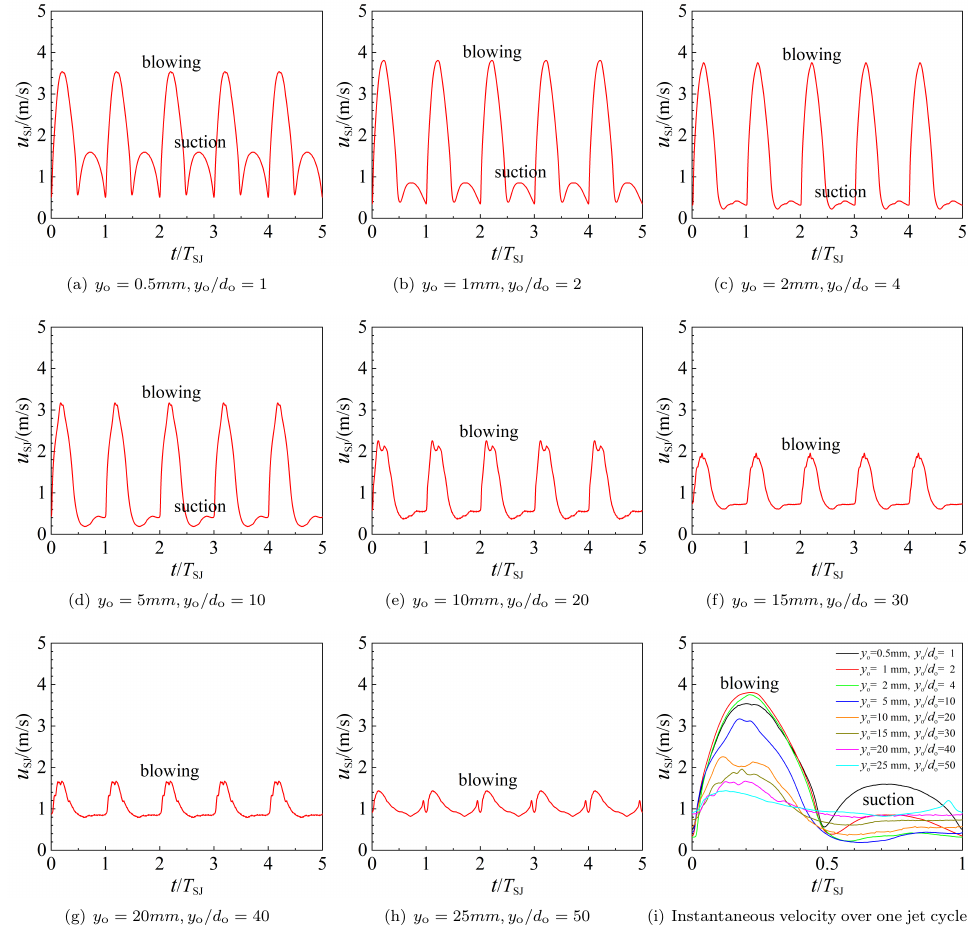
Figure 11. Jet instantaneous velocity at orifice